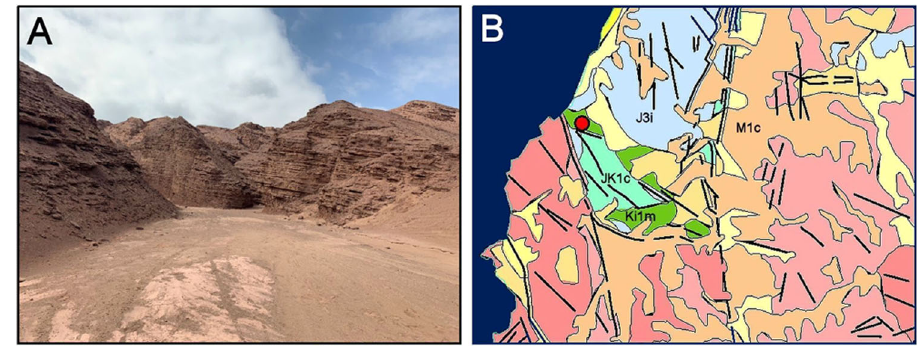
Fig. 2 | Red Stone site characteristics. A Panoramic view of the inspected site. B Geological map of the Caleta Coloso-El Way formation (SERNAGEOMIN, 2003. Mapa Geológico de Chile: versión digital 88 ). JK1c (light green); transitional alluvial, fl uvial and aeolic sedimentary sequences. Early Cretaceous to Late Jurassic (sand- stone, limestone, lutite, conglomerate, siltstone). Ki1m (green); coastal marine